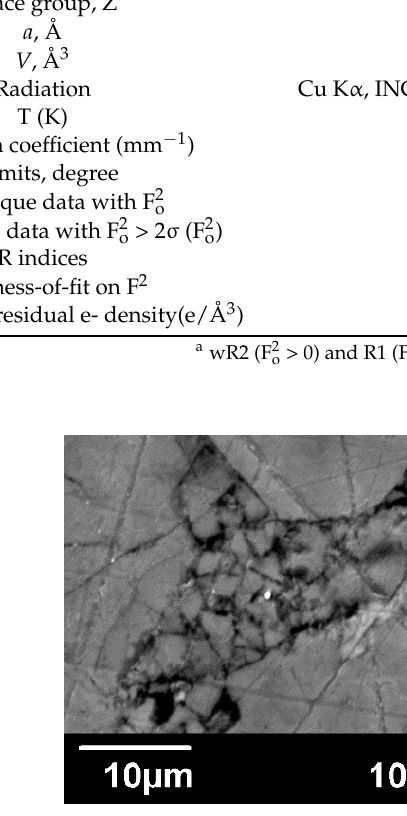
Figure 3. SEM image after the surface of the K 2.9(4) Ba 13.1(2) Ga 23.2(3) Sn 112.7(5) specimen was cracked and roughed in order to reveal the grains.